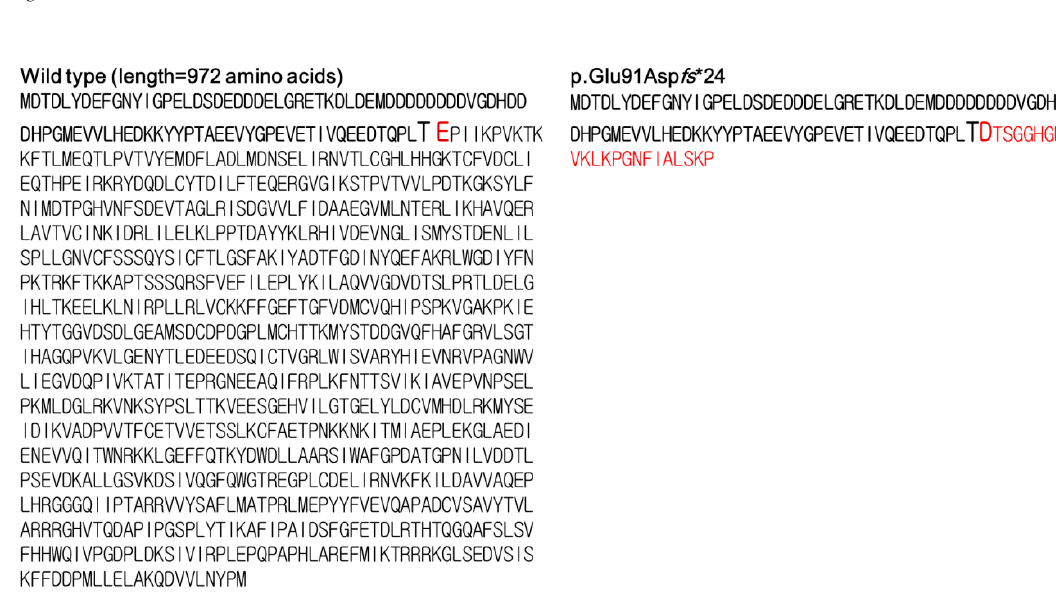
Figure 6. In silico prediction of the effect of the c.271+1G>A variant on translation, compared to the wild-type. The full protein ( left ) was expected to be truncated ( right ) in the c.271+1G>A variant. The red letters were indicated the amino acid residues that were altered due to the aberrantly spliced product.